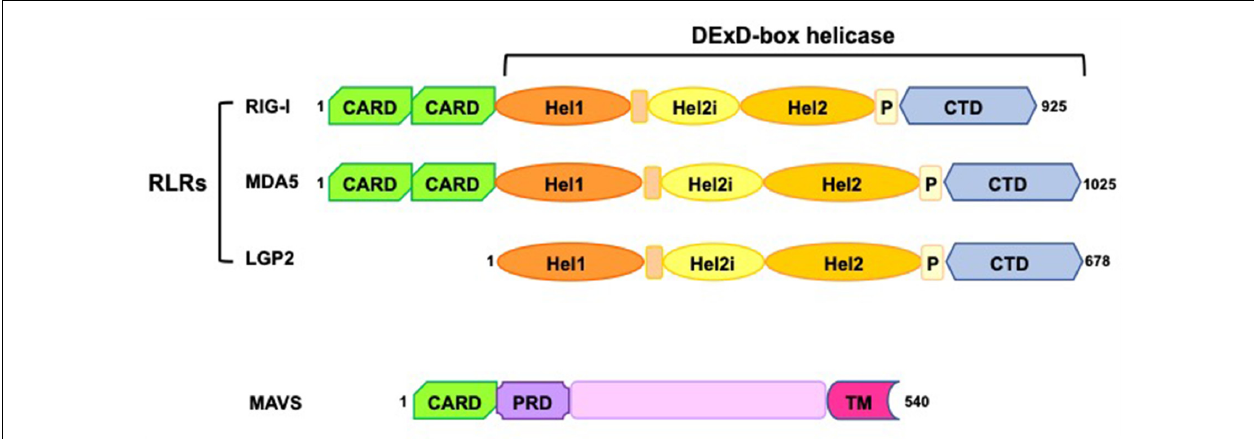
FIGURE 1 | Schematic representation of RIG-I-like receptors (RLRs) and mitochondrial antiviral-signaling protein (MAVS) domains. RLRs have a central DExD-box helicase containing: (i) two conserved helicase domains (Hel1 and Hel2); (ii) a helicase insertion domain (Hel2i) with ATPase activity; (iii) a pincer domain (P); (iv) a C-terminal domain (CTD). Both the helicase domains and the CTD have RNA binding ability. RIG-I and MDA5 have two N-terminal caspase activation and recruitment domains (CARDs), essential for the interaction with MAVS and the induction of downstream signaling. MAVS consists of a single CARD, a proline-rich region (PRD), and a C-terminus transmembrane domain (TM) required for its tethering to mitochondria, mitochondrial-associated membranes (MAM), and